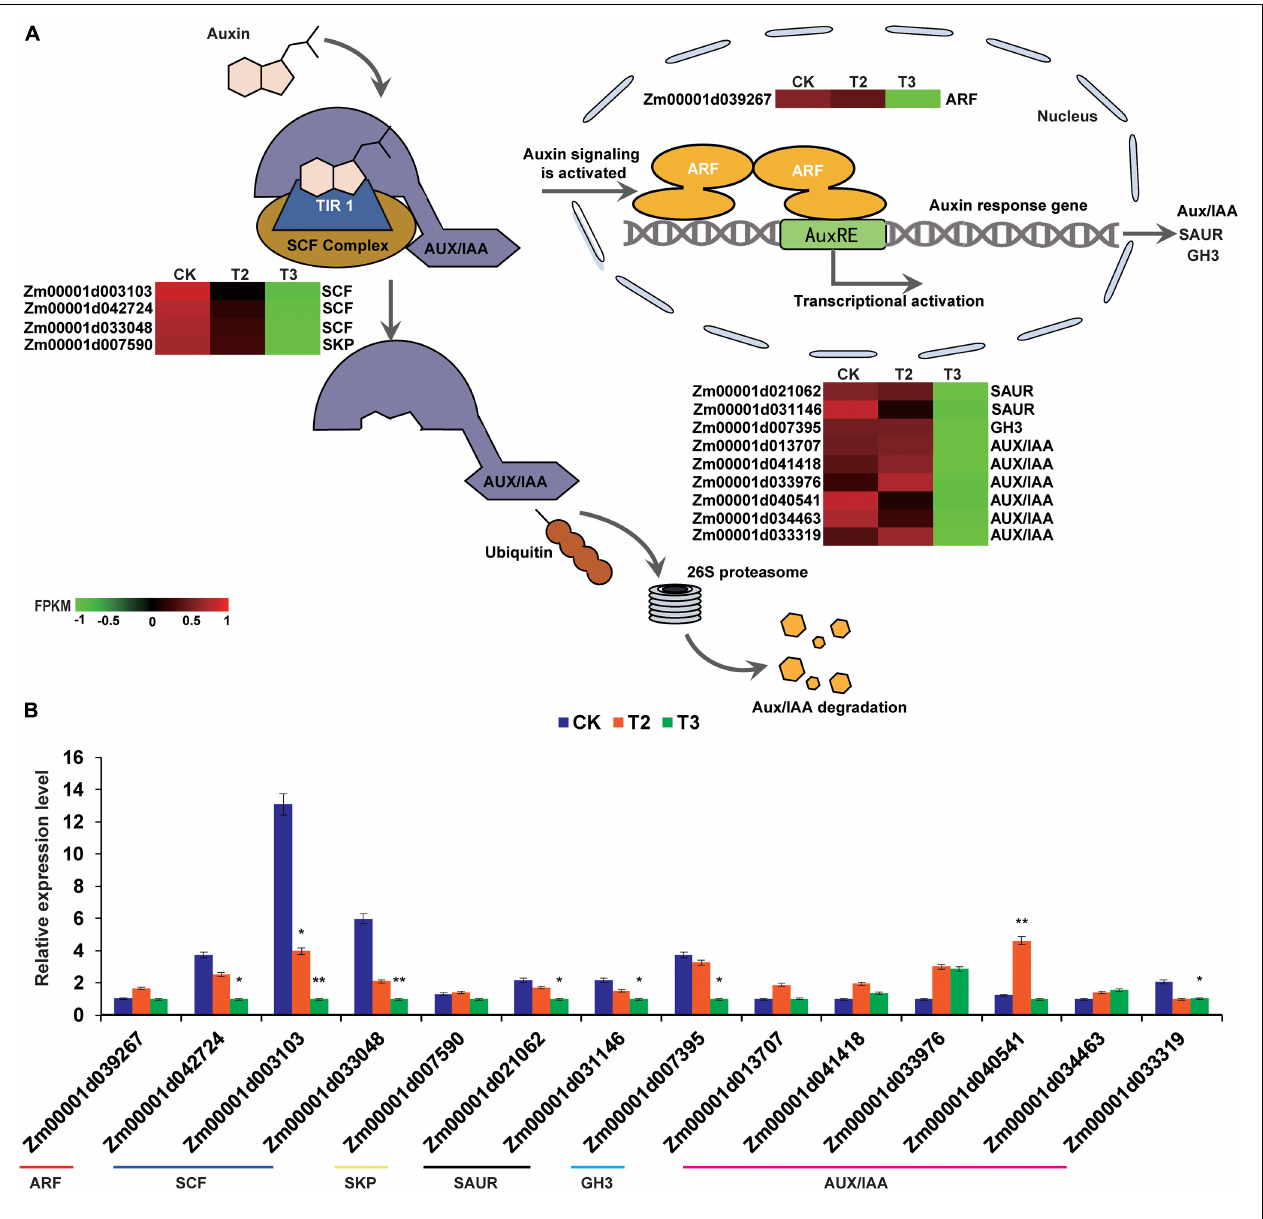
FIGURE 6 | Expression profiles of auxin signaling transduction-related genes in CK, T2, and T3 samples. (A) Schematic diagram of auxin signal transduction and RNA-seq expression profiles. Auxin molecules recruit AUXIN/INDOLE ACETIC ACID (Aux/IAA) and transport inhibitor response (TIR) and bind with the SKP-Cullin-F-box (SCF) complex; Aux/IAA is subsequently labeled with ubiquitin, as well as recognized and degraded by the 26 S proteasome (Dharmasiri and Estelle, 2004). The heatmap was constructed using the FPKM, and the color from green to red represents the gene expression levels from low to high. (B) DEGs involved in auxin signal transduction are verified by qRT-PCR. The statistical significance was determined using SPSS 16.0 with a one-way analysis of Tukey’s test. * represents p ≤ 0.05; ** represents p ≤ 0.01. The x-axis represents Se application treatments (CK, T2, and T3), and the y-axis indicates the relative expression levels. Error bar shows the SEs of three biological